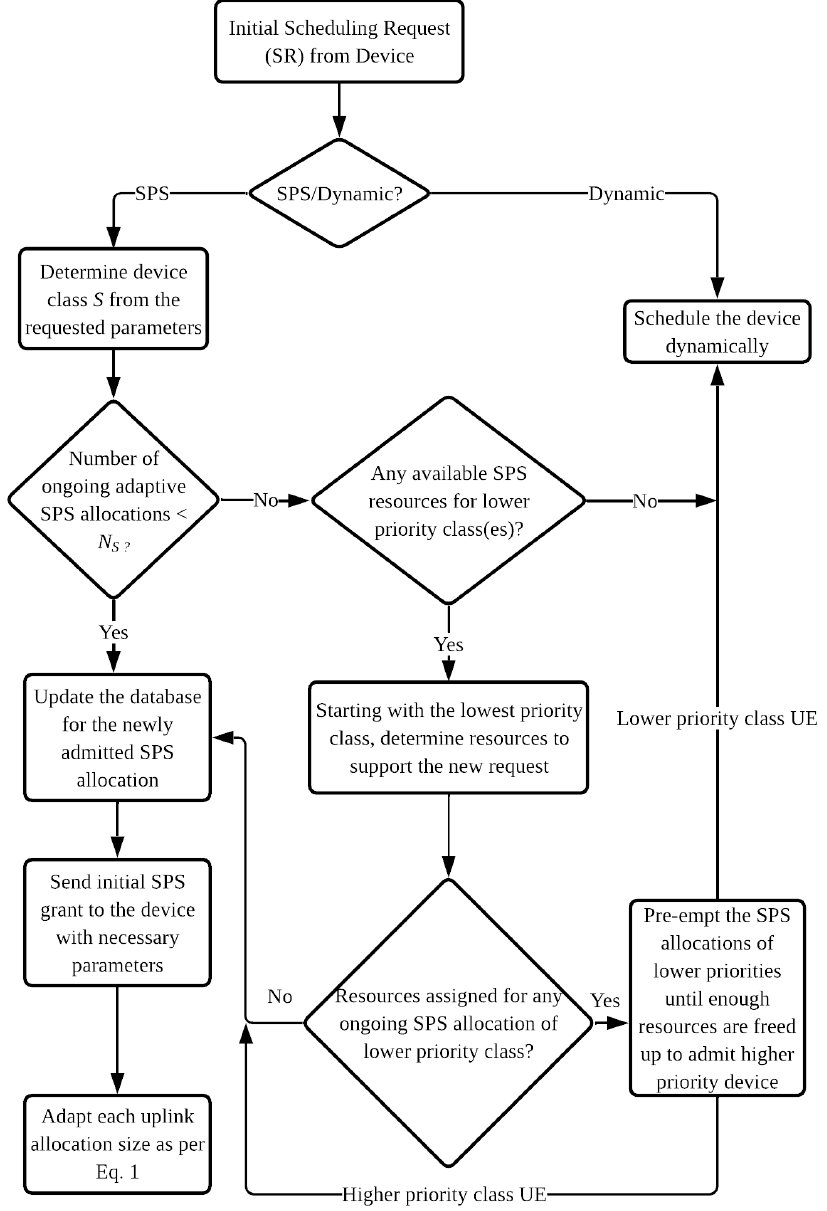
Figure 4. Multi-service adaptive Semi-Persistent Scheduling (SPS) algorithm with pre-emptive